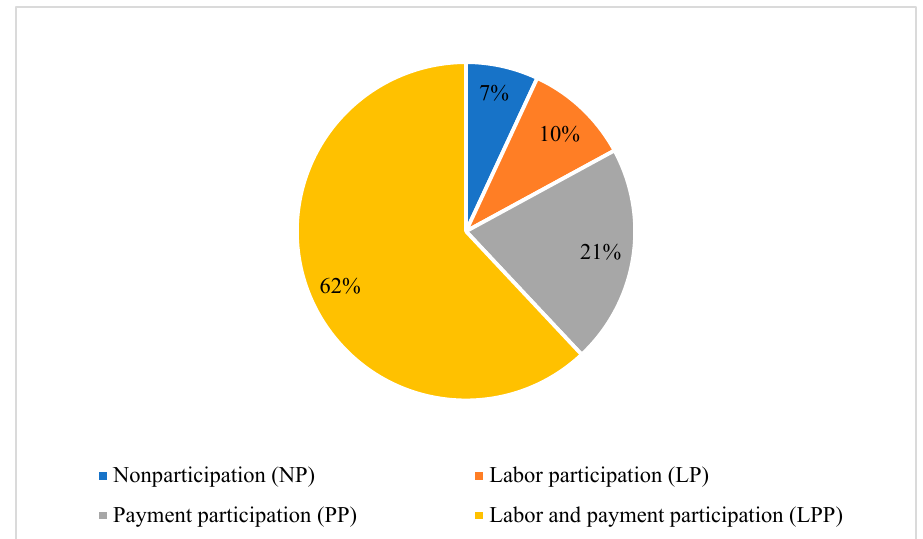
Figure 2. Distribution of participation preferences for rural solid waste management.